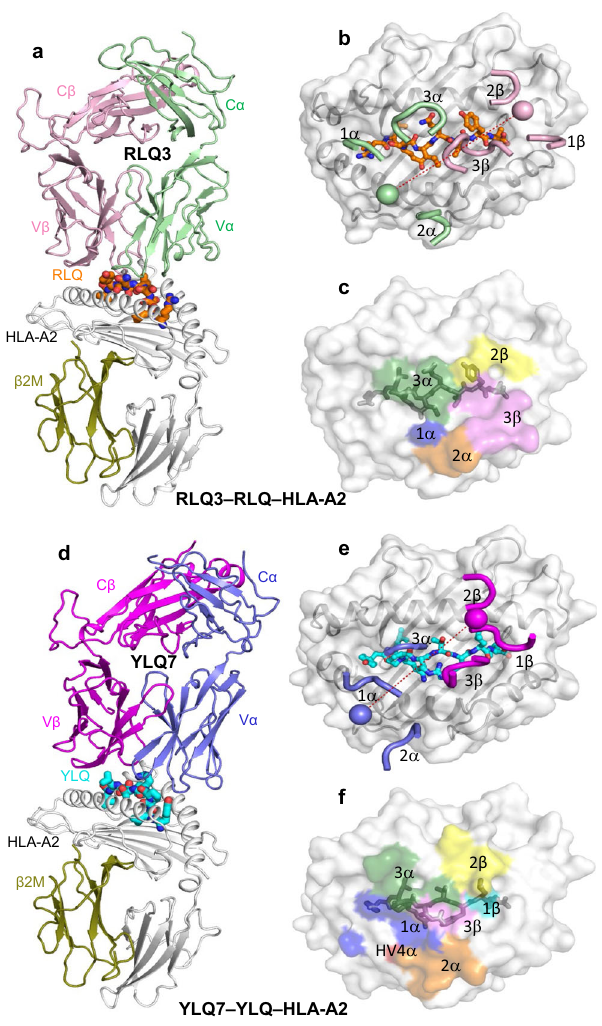
Fig. 4 Structure of RLQ3 – RLQ – HLA-A2 and YLQ7 – YLQ – HLA-A2 complexes. a Side view of RLQ3 – RLQ – HLA-A2 complex (ribbon diagram). TCR α chain, green; TCR β chain, pink; HLA-A2 heavy chain, gray; β 2 - microglobulin ( β 2 m), olive. The RLQ peptide is orange. b Positions of CDR loops of TCR RLQ3 on RLQ – HLA-A2 (top view). CDRs of RLQ3 are shown as numbered green (CDR1 α , CDR2 α , and CDR3 α ) or pink (CDR1 β , CDR2 β , and CDR3 β ) loops. HLA-A2 is depicted as a gray surface. The RLQ peptide is drawn in orange in stick representation. The green and pink spheres mark the positions of the conserved intrachain disul fi de of the V α and V β domains, respectively. The red dashed line indicates the crossing angle of TCR to pMHC. c Footprint of TCR RLQ3 on RLQ – HLA-A2. The top of the MHC molecule is depicted as a gray surface. The areas contacted by individual CDR loops are color-coded: CDR1 α , blue; CDR2 α , orange; CDR3 α , green; HV4 α , red; CDR1 β , cyan; CDR2 β , yellow; CDR3 β , pink. d Side view of YLQ7 – YLQ – HLA-A2 complex. TCR α chain, blue; TCR β chain, magenta. The YLQ peptide is cyan. e Positions of CDR loops of TCR YLQ7 on YLQ – HLA-A2 (top view). f Footprint of TCR YLQ7 on YLQ – HLA-A2.